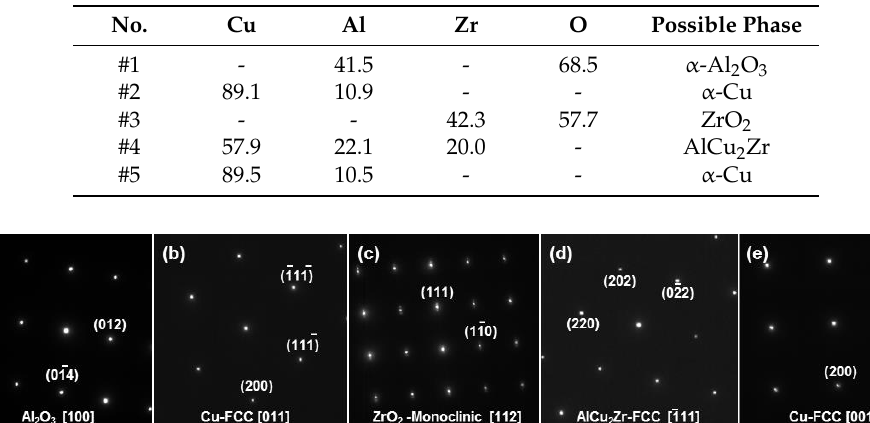
Figure 8. ( a – e ) Corresponding diffraction patterns obtained from areas labelled #1–#5 in Figure 7, respectively.